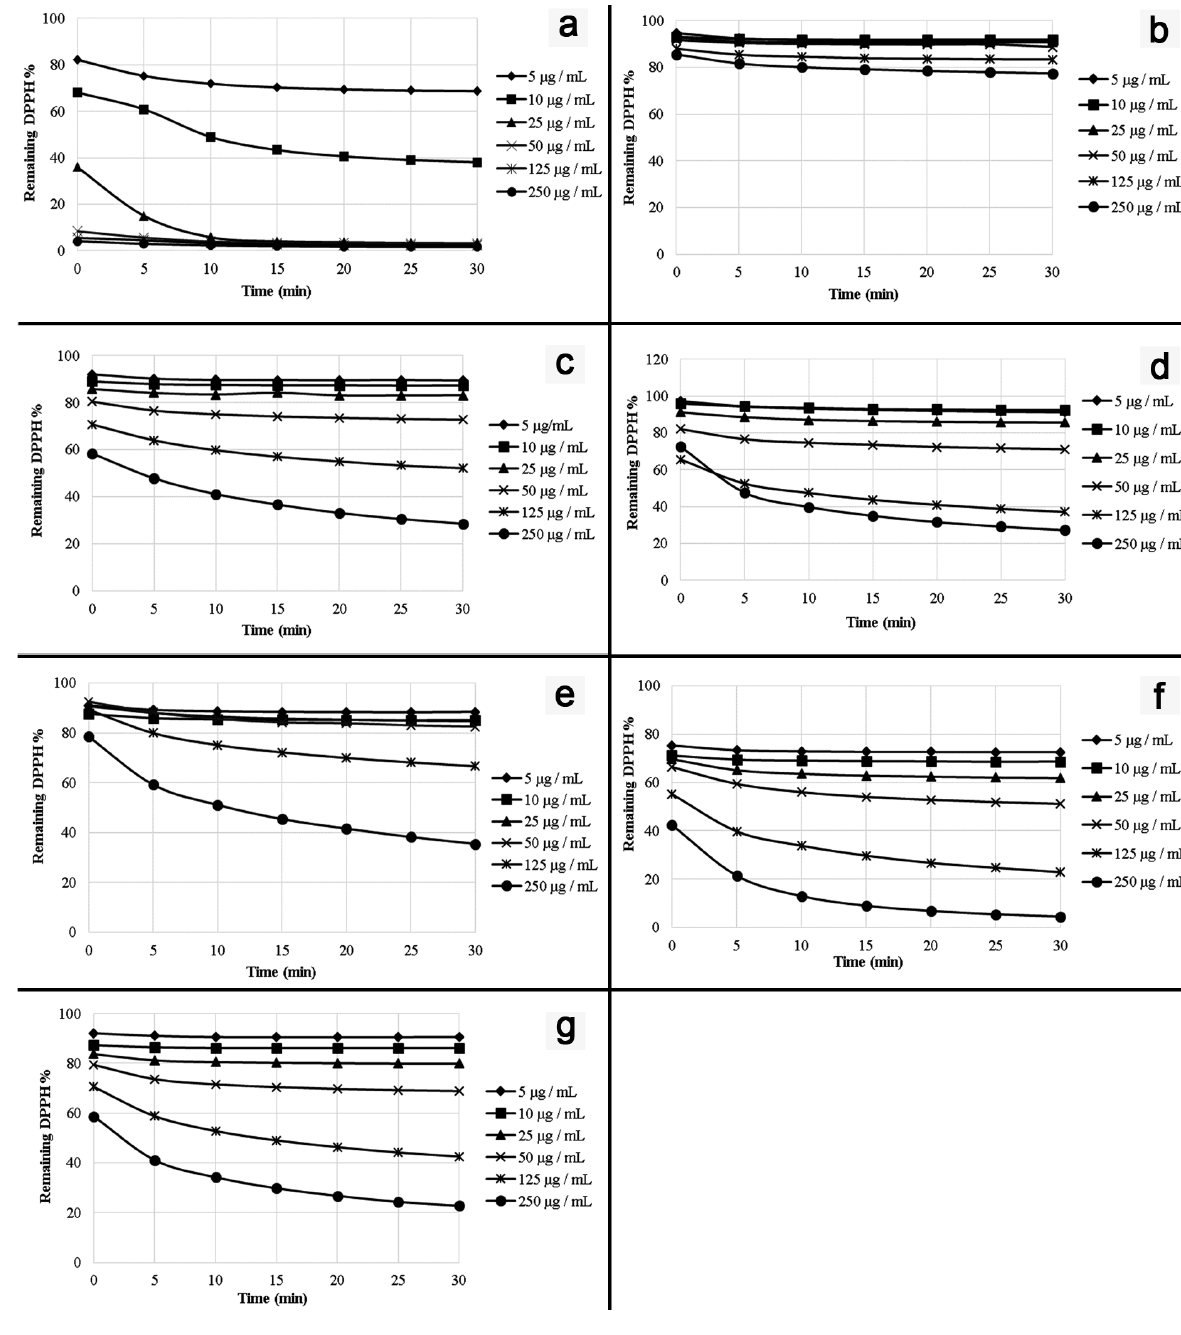
Figure 3 - Reaction kinetics with DPPH (2,2-diphenyl-1-picrylhydrazyl) . ( a ) Rutin. ( b ) CCLH: crude hexanic extract of leaves. ( c ) CCPH: crude hexanic extract of pericarps. ( d ) CCSH: crude hexanic extract of seeds. ( e ) CCLM: crude methanolic extract of leaves. ( f ) CCPM: crude methanolic extract of pericarps. ( g ) CCSM: crude methanolic extract of